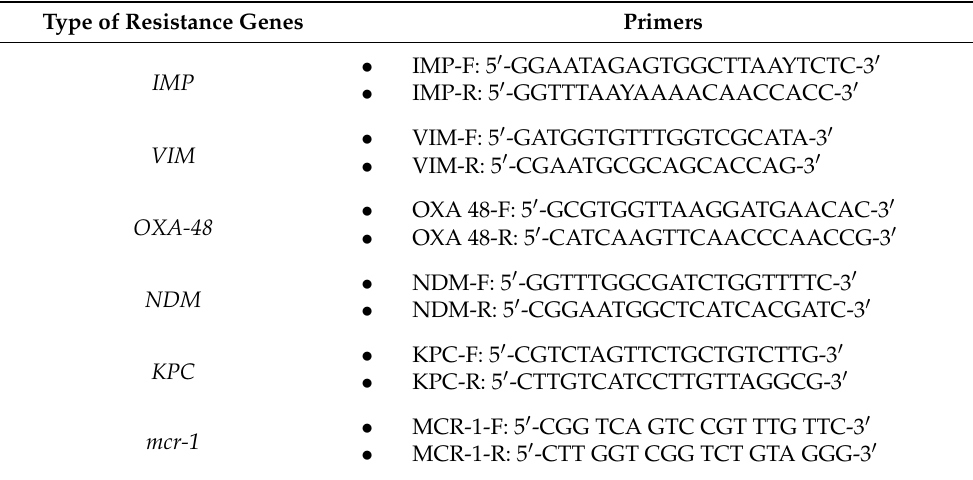
Table 1. Primer sets for detection genes of antibiotic resistance [29,30]. Type of Resistance